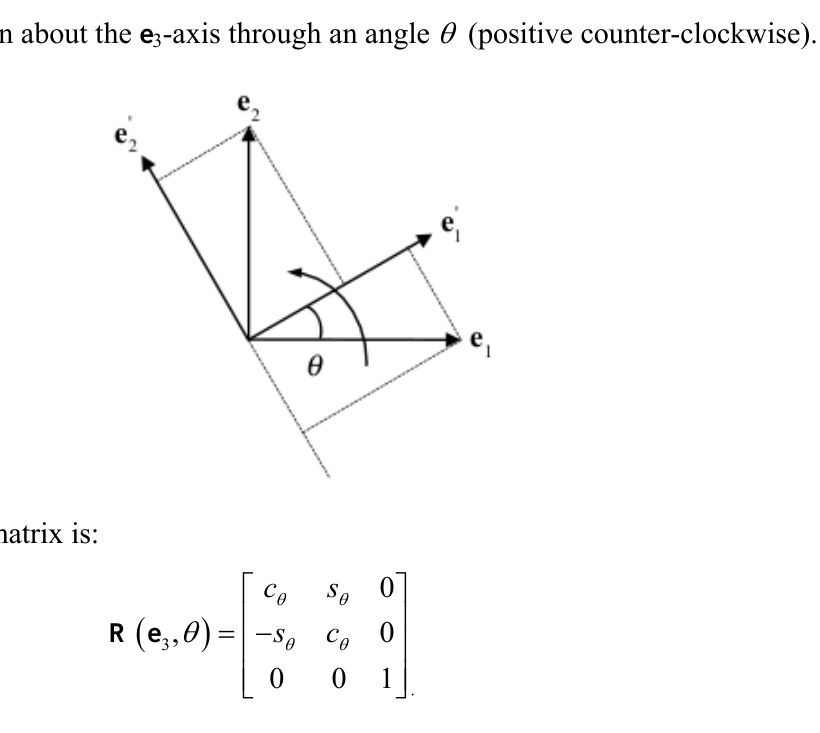
Figure 2. Rotation about the e